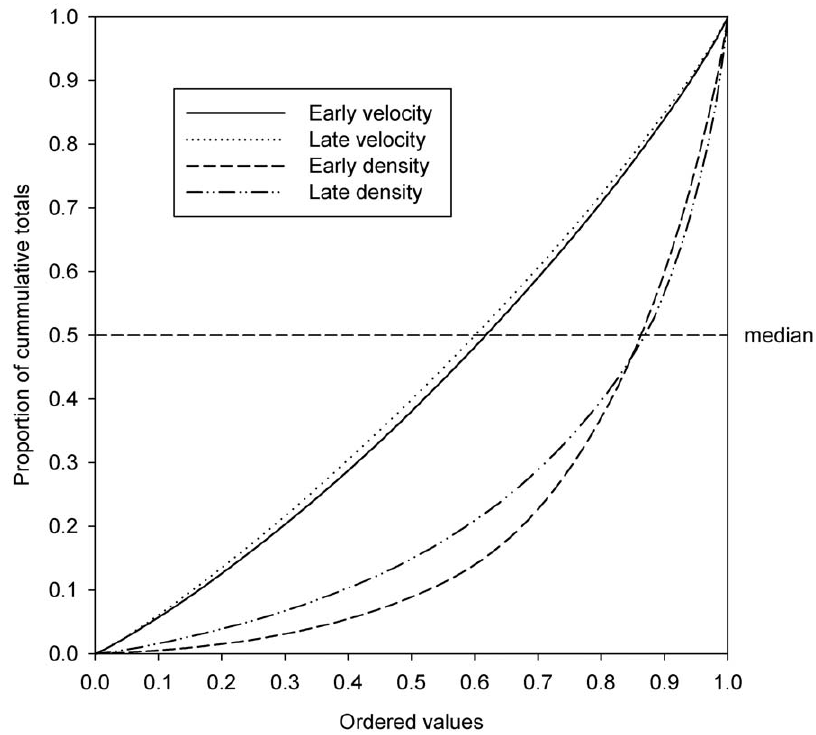
Figure 3. Lorenz curves for insect displacement speeds and densities by period.